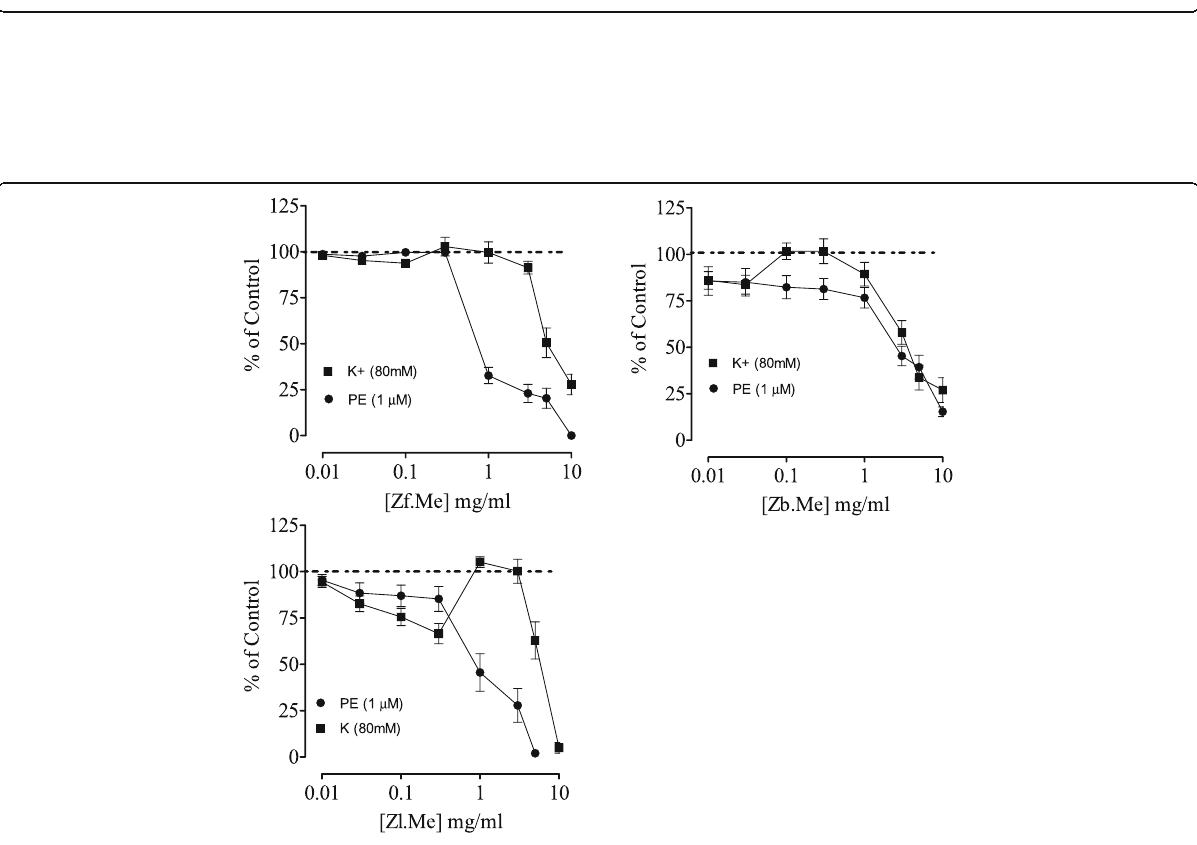
Fig. 2 The effect of extracts of Z. armatum fruit (Zf), bark (Zb), leaves (Zl) extracts and verapamil on carbocbol (CCh) and high K + induced contractions in isolated rabbit trachea preparation (All values are expresses as the mean±SEM; n =5)